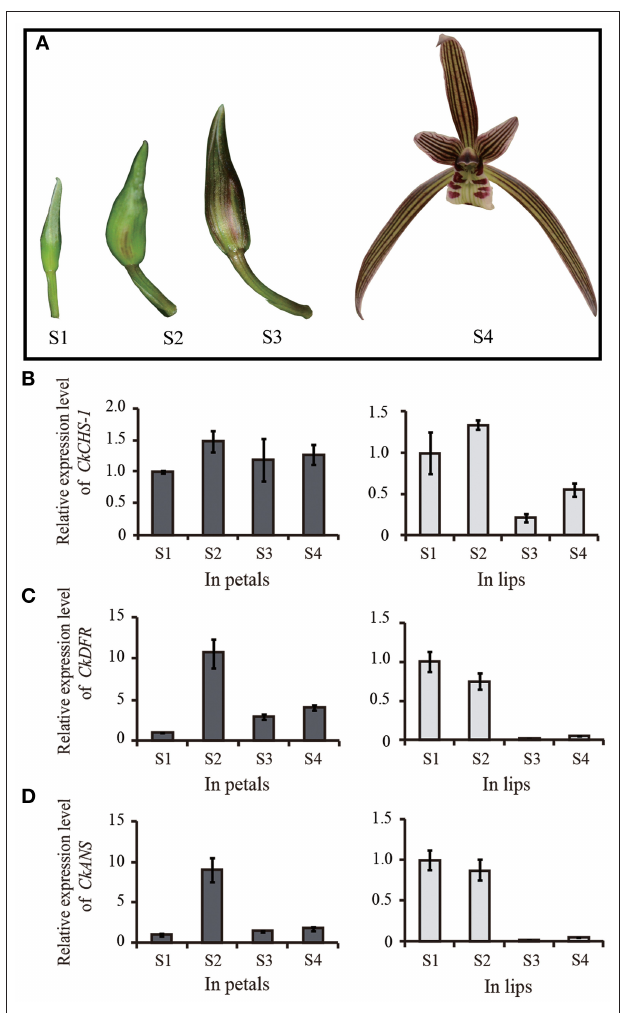
FIGURE 8 | CkCHS-1 , CkDFR , and CkANS expression levels were measured by qRT-PCR in four stages. (A) Four development stages of purple-red flower. (B–D) The relative expression level of CkCHS-1 , CkDFR , and CkANS in four development stages of petals and lips of purple-red flower, respectively. Four developmental stages: stage 1 (S1, bud length of approximately 2cm), stage 2 (S2, bud length of approximately 3cm), stage 3 (S3, 1–2 days before anthesis), and stage 4 (S4, the flower